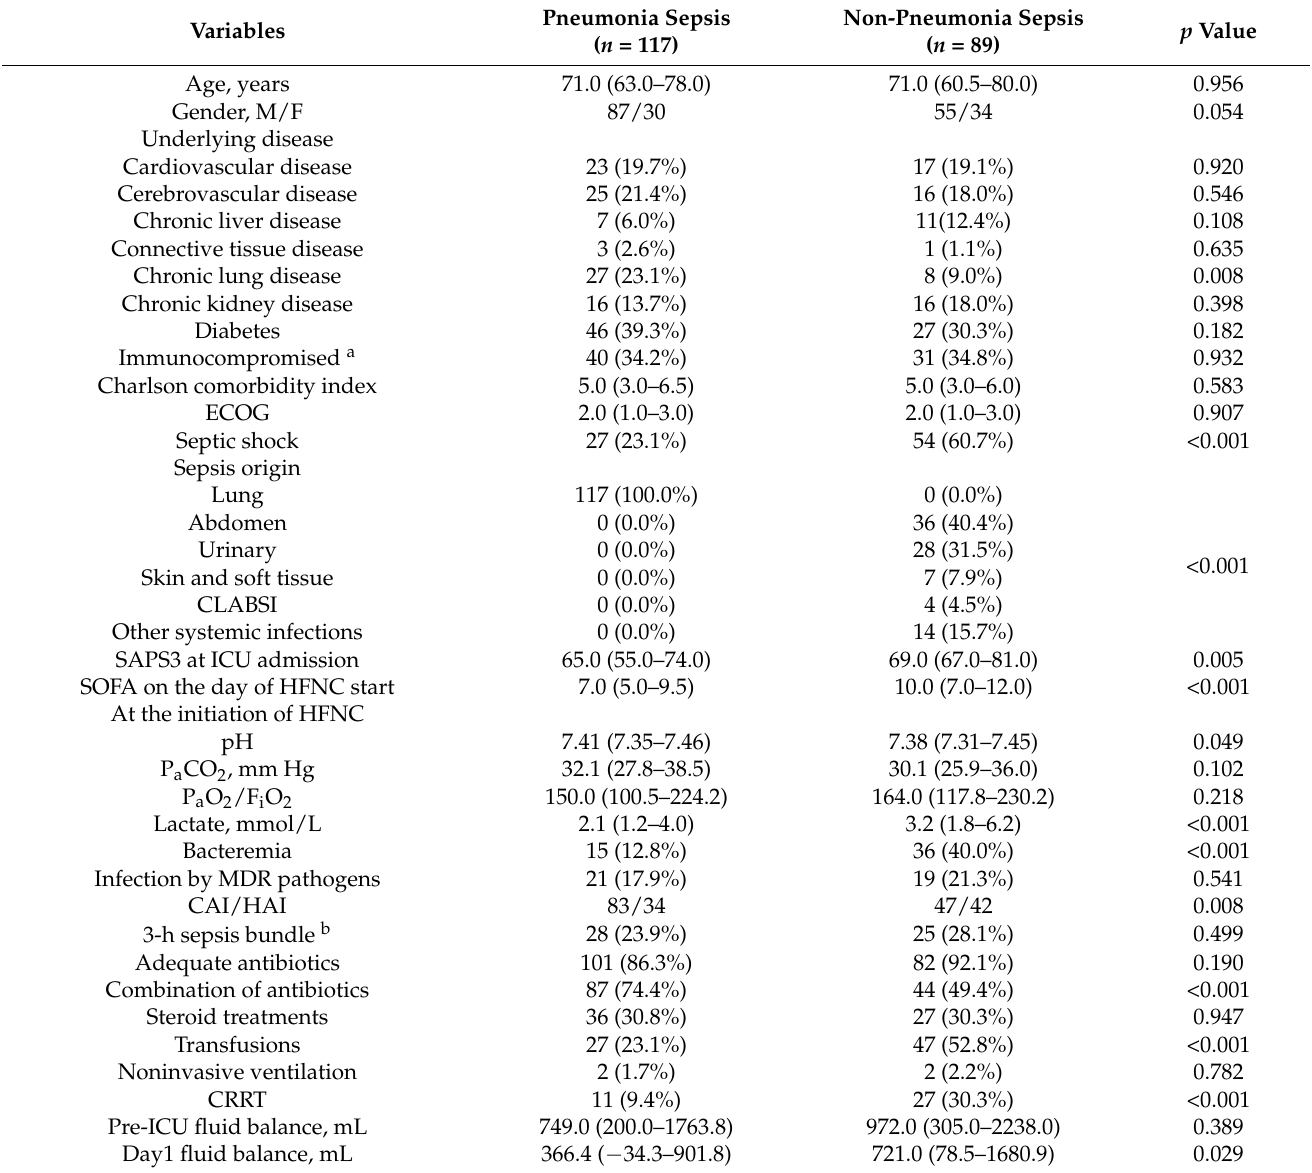
Table 1. Baseline characteristics and treatments among enrolled patients ( n =